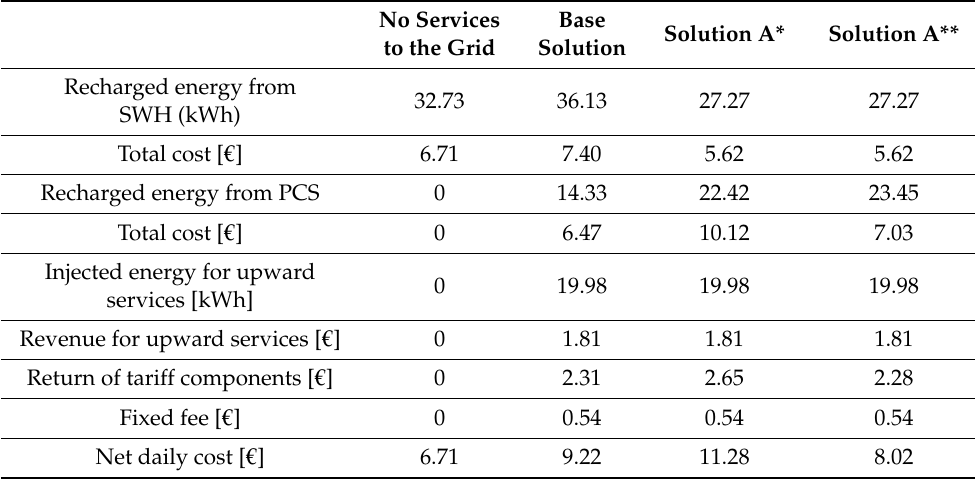
Table 24. Results for mobility pattern 2—UVAM (Scenario